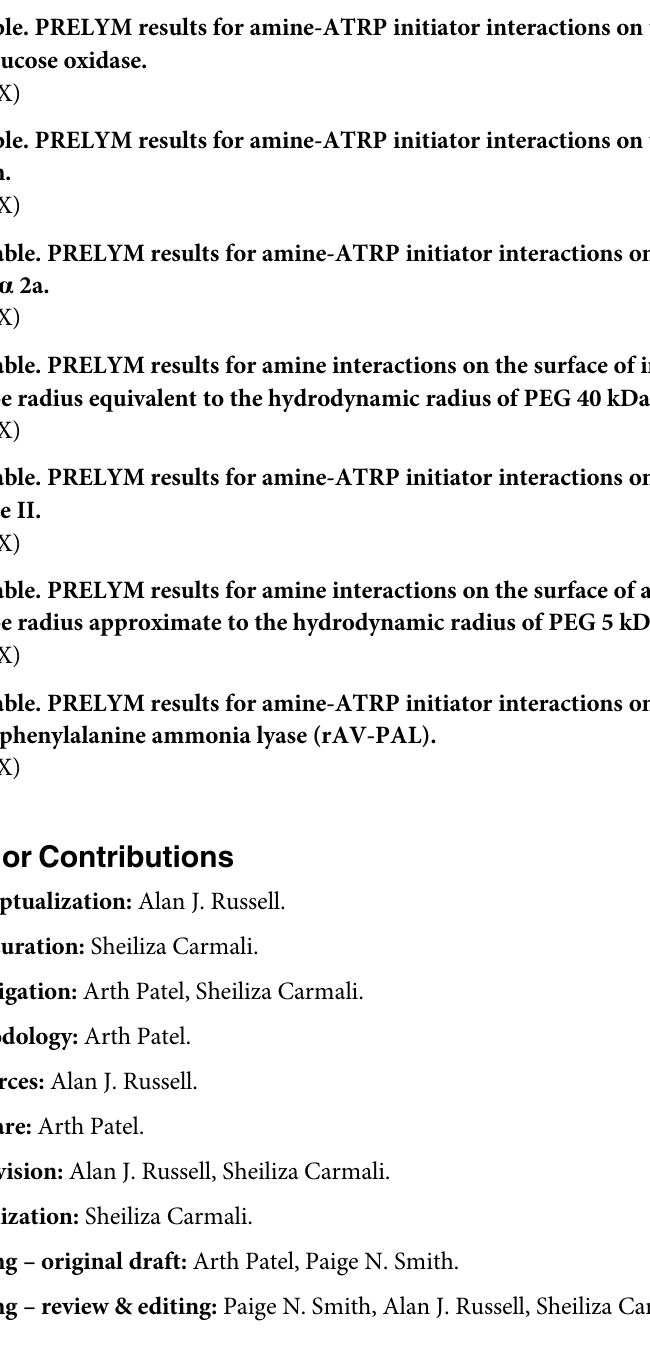
S7 Table. PRELYM results for amine interactions on the surface of monomer chymotryp-